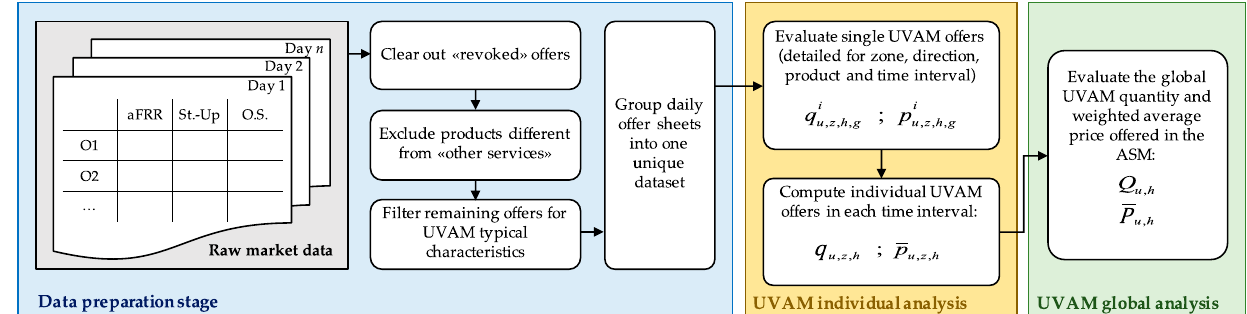
Figure 1. Market data elaboration methodology.